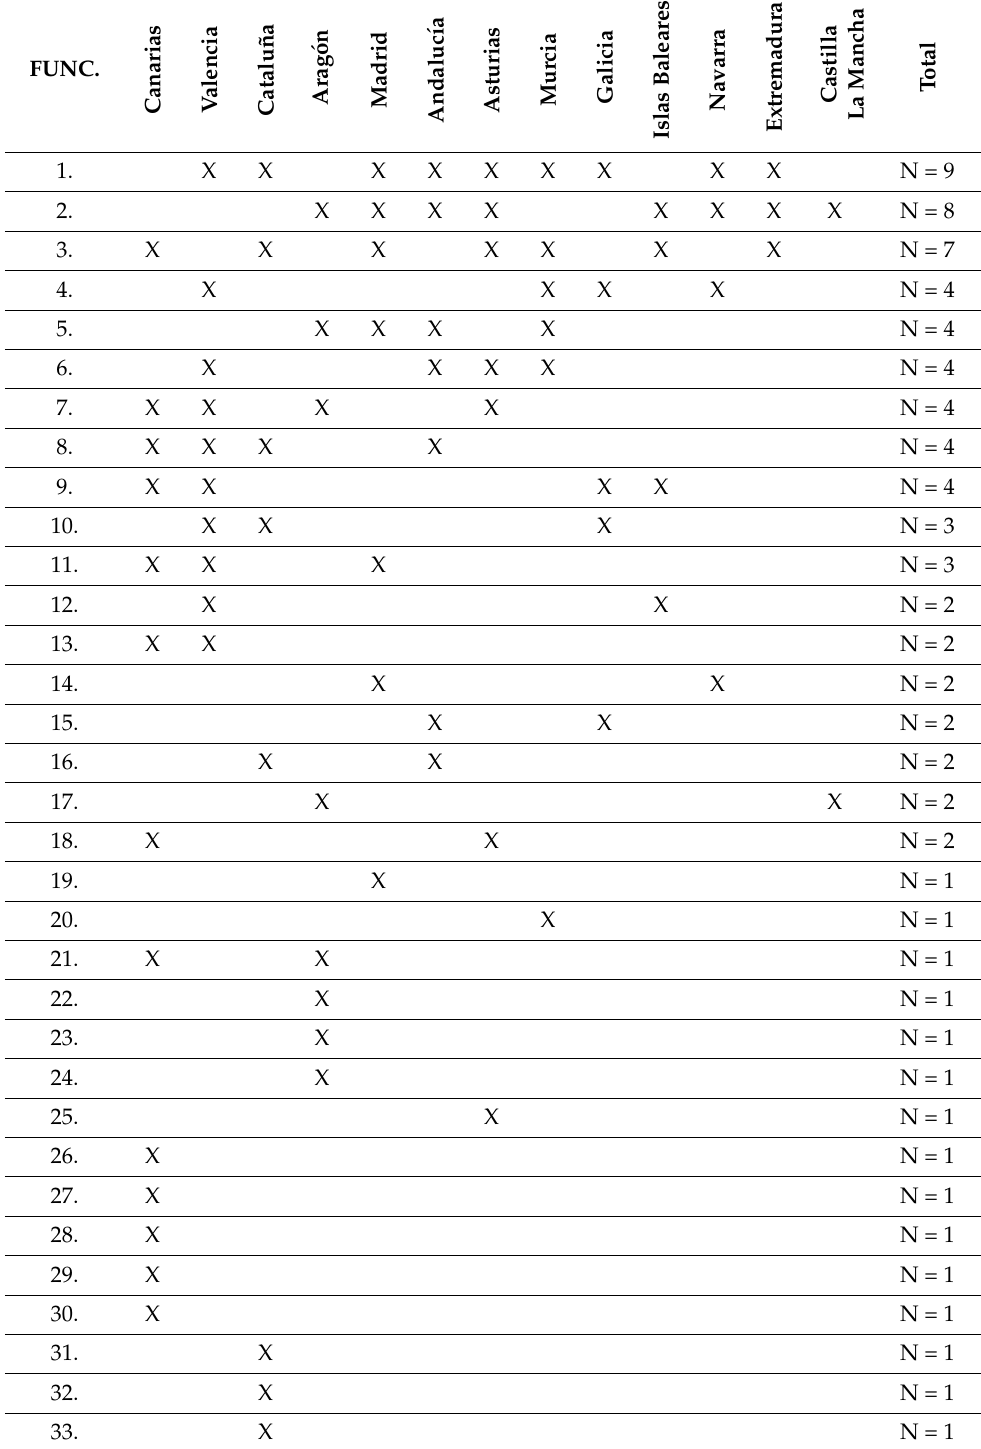
Table 3. Functions of CTIC in the Autonomous Communities.